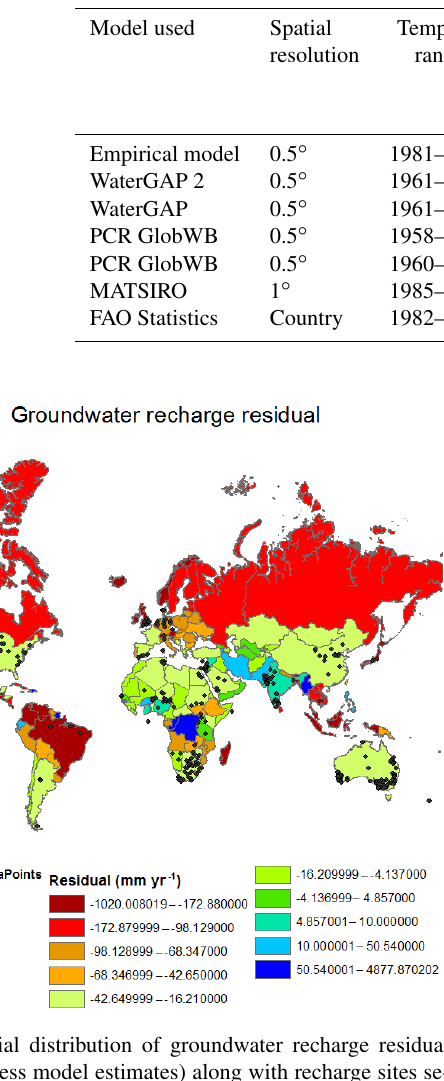
Table 4. Global estimates of groundwater recharge.